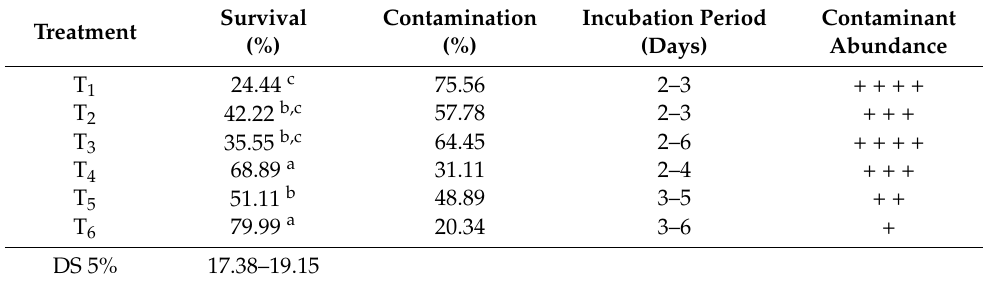
Table 6. Influence of disinfection treatments of the PFP sprout explants.